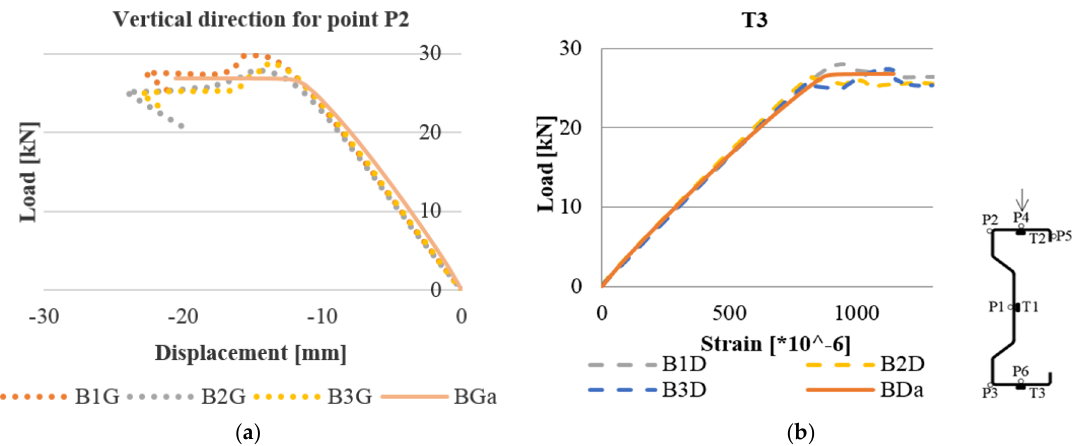
Figure 13. Comparison of laboratory and numerical tests at an analogous point for reinforced beams in the web: ( a ) load–displacement for point P2 in the vertical direction; ( b ) load–strain for the T3 strain gauge.